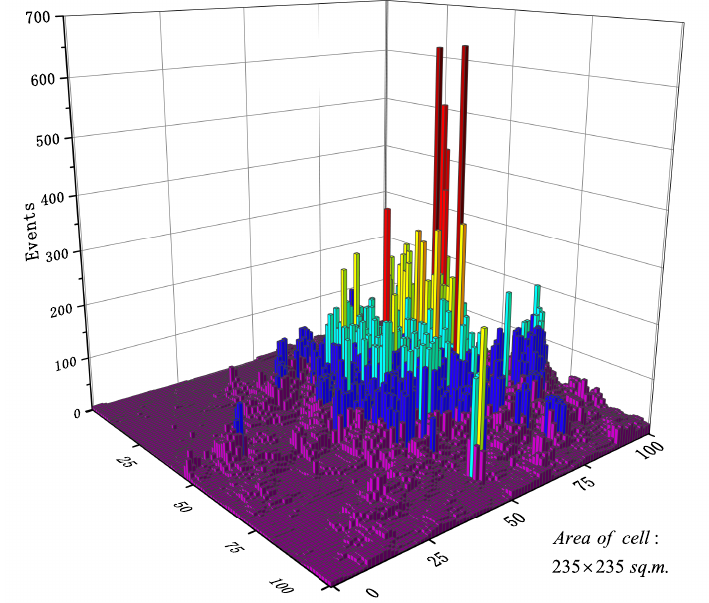
Figure 3. Spatial distribution of cellular network